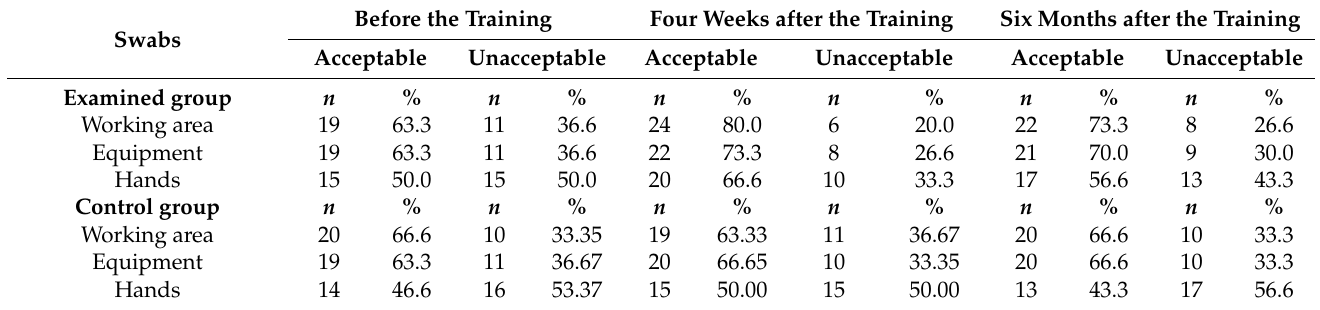
Table 5. TBC of swabs of work surfaces, equipment, and hands of food handlers for